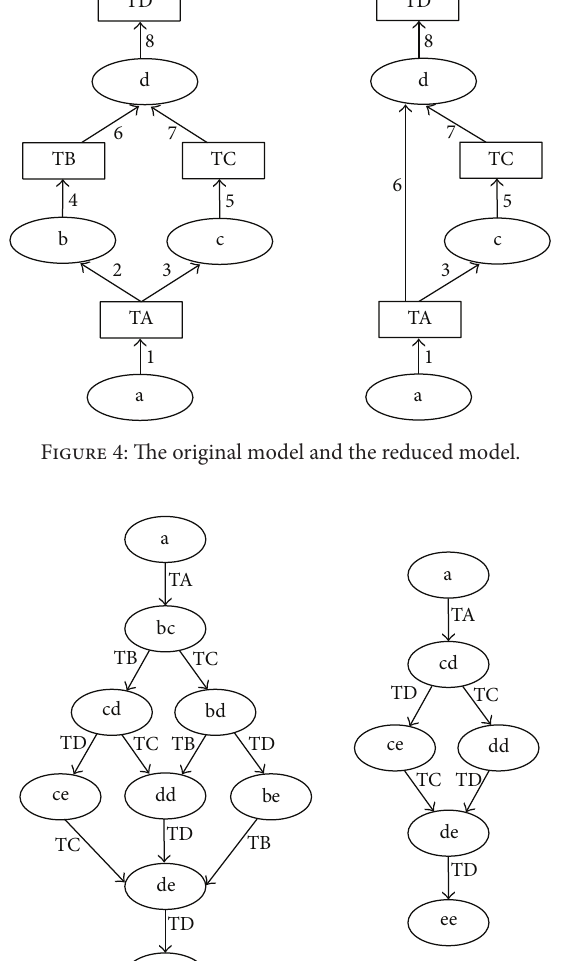
changed from {𝑏} to {𝑎} . Both {𝑎} and {𝑏} are in the function of 𝐹3 󸀠 ({𝑎}) ; however, {𝑎} is the real variable of the arc, and {𝑏} is the temporary local variable of the function which is not variable of arc for binding when transition